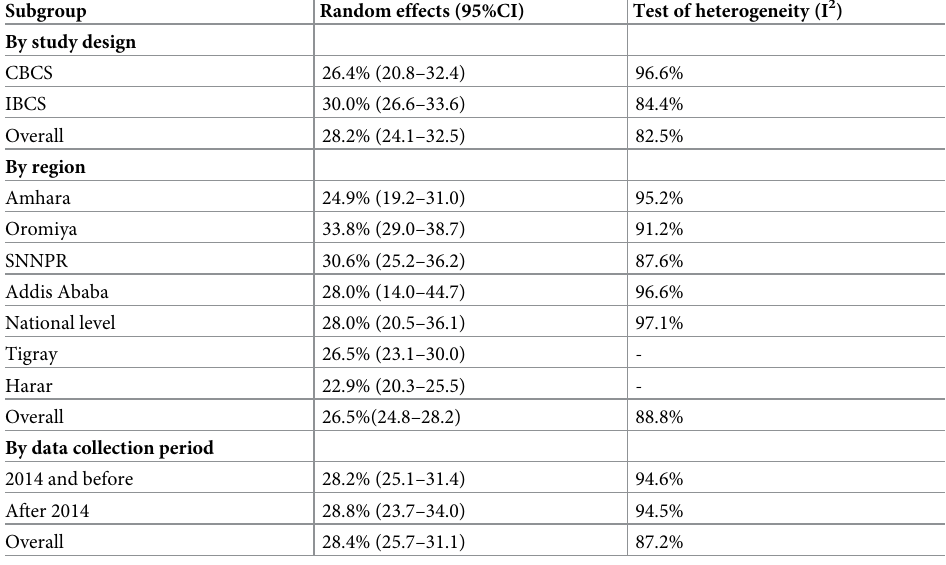
Table 2. Subgroup analysis of studies included in meta-analysis on prevalence and determinants of unintended pregnancy in Ethiopia.